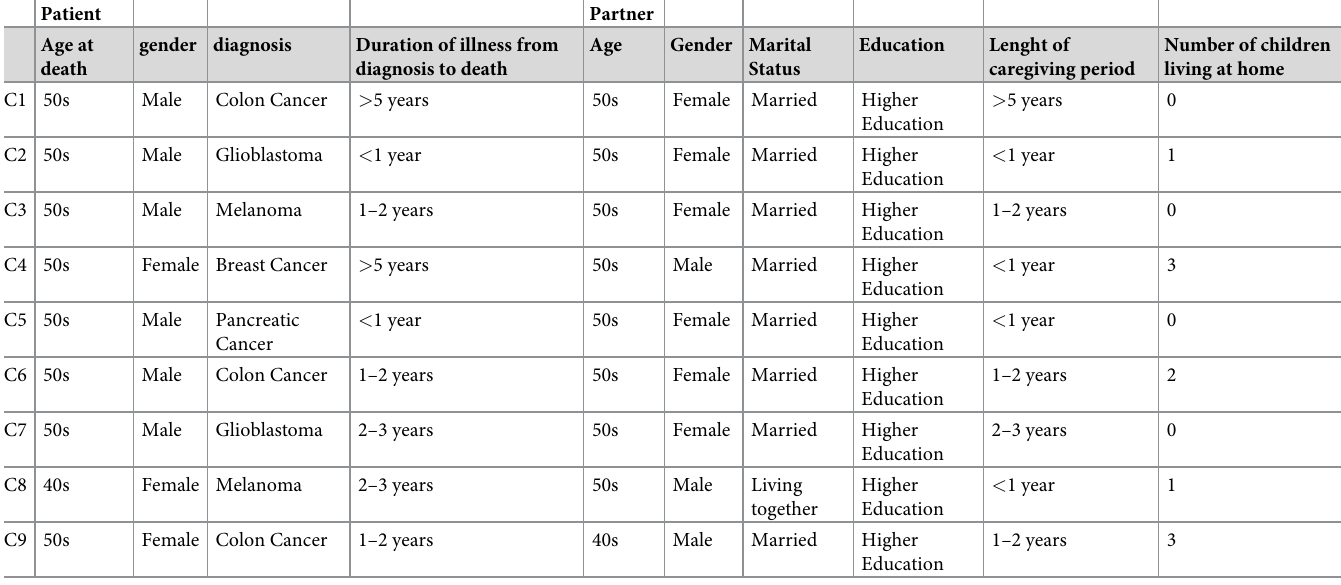
Table 3. Patients’ and their co-habiting partners’ demographic